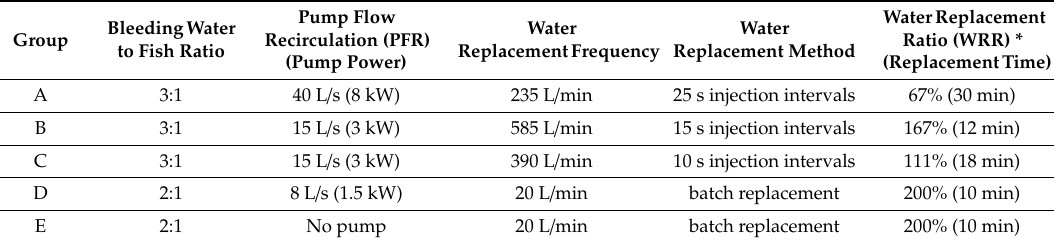
Table 1. Experiment groups